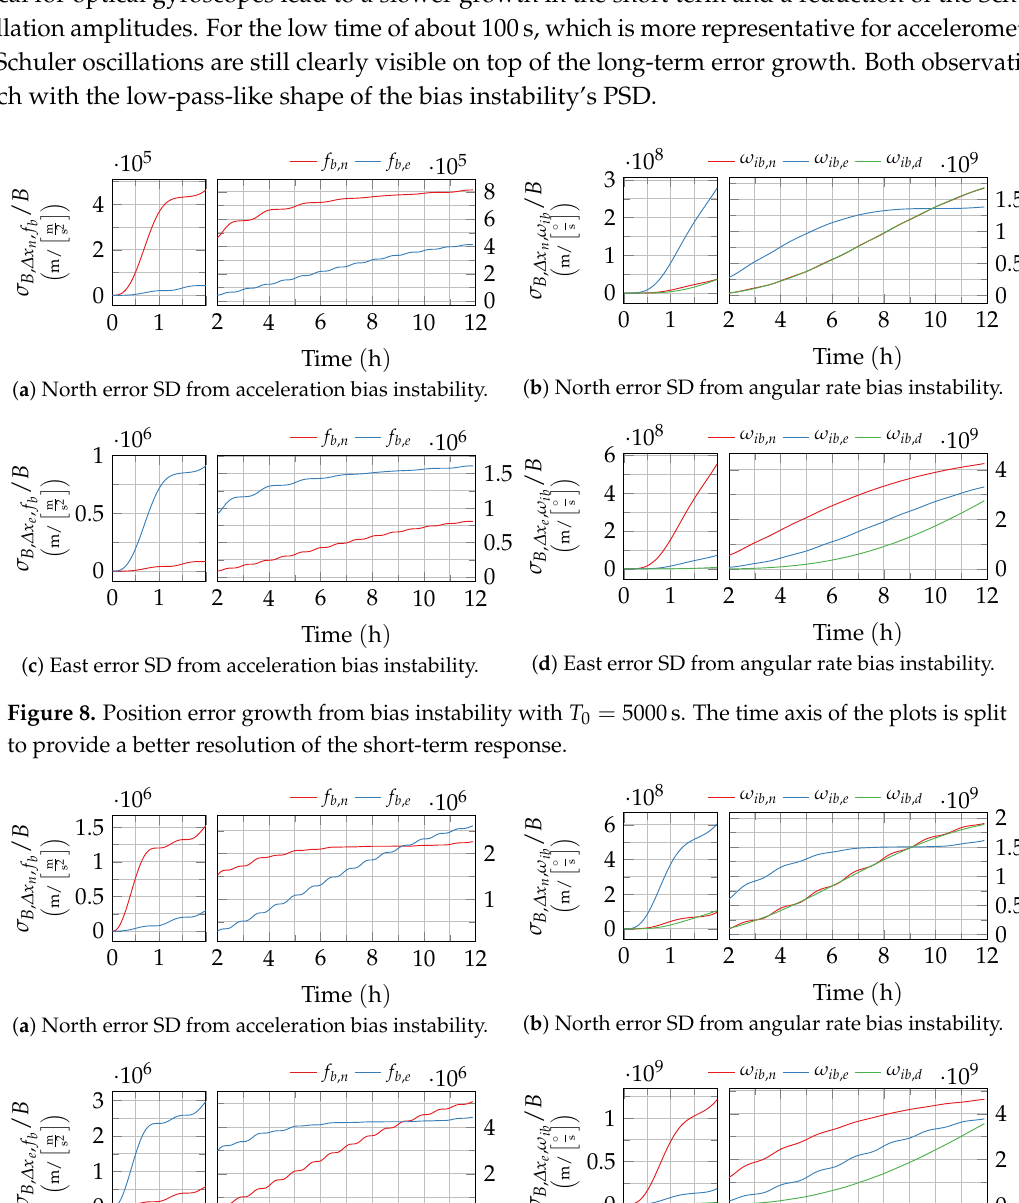
( a ) North error SD from acceleration bias instability. ( b ) North error SD from angular rate bias instability.